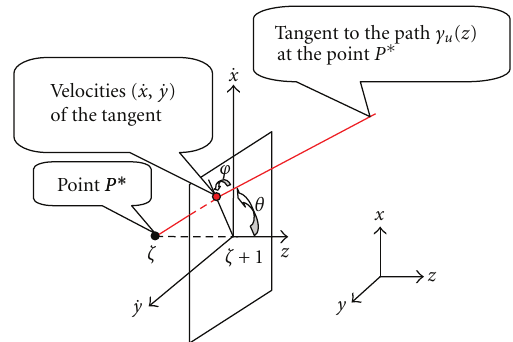
Figure 2: Direction of the tangent to a path γ u ( z ) at a given point P ∗ ( γ u ( ζ ), ζ ) can be characterized by angles ( θ , ϕ ) of the spherical coordinate system ( ϕ ∈ (0,2 π ), θ ∈ (0, π/ 2)), or by “velocities” (˙ x , ˙ y